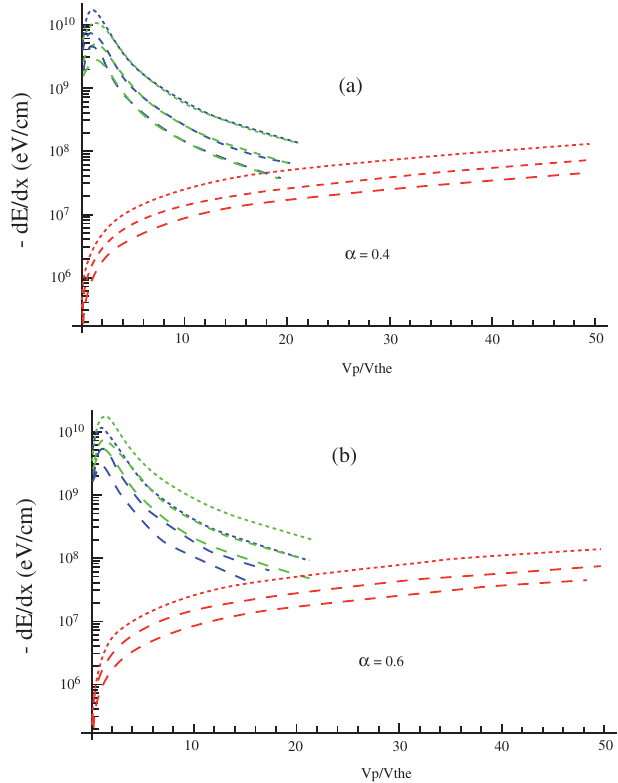
FIG. 2. (Color) Proton particle projectile in a deuterium-tritium BIM with n e ¼ 10 26 e cm (cid:1) 3 and temperatures ¼ ( ) 1 keV, ( ) 2 keV, ( ) 10 keV with D þ relative proportion: (a) (cid:1) ¼ 0 : 4 and (b) (cid:1) ¼ 0 : 6 . Dark gray (red) refers to electron stopping, light gray (green) to D þ stopping, and black (blue) denotes T þ stopping, (cid:1) dE=dx ( eV = cm ) in terms of =V V p the